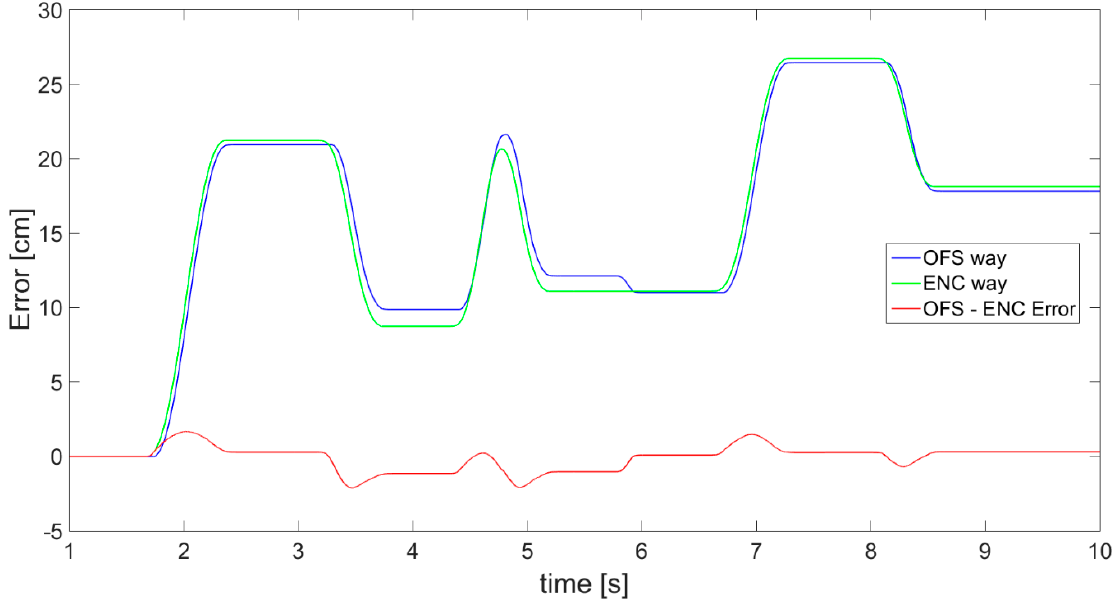
Figure 21. Results of displacement: estimated with OFS (blue), measured with encoder (green), and calculated difference between them (red).